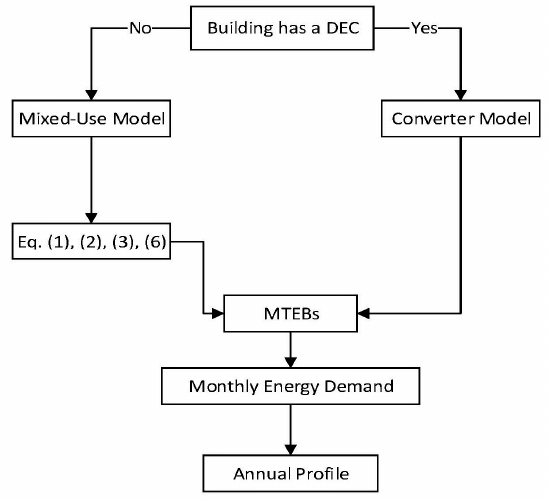
Figure A1. The flowchart of model application.